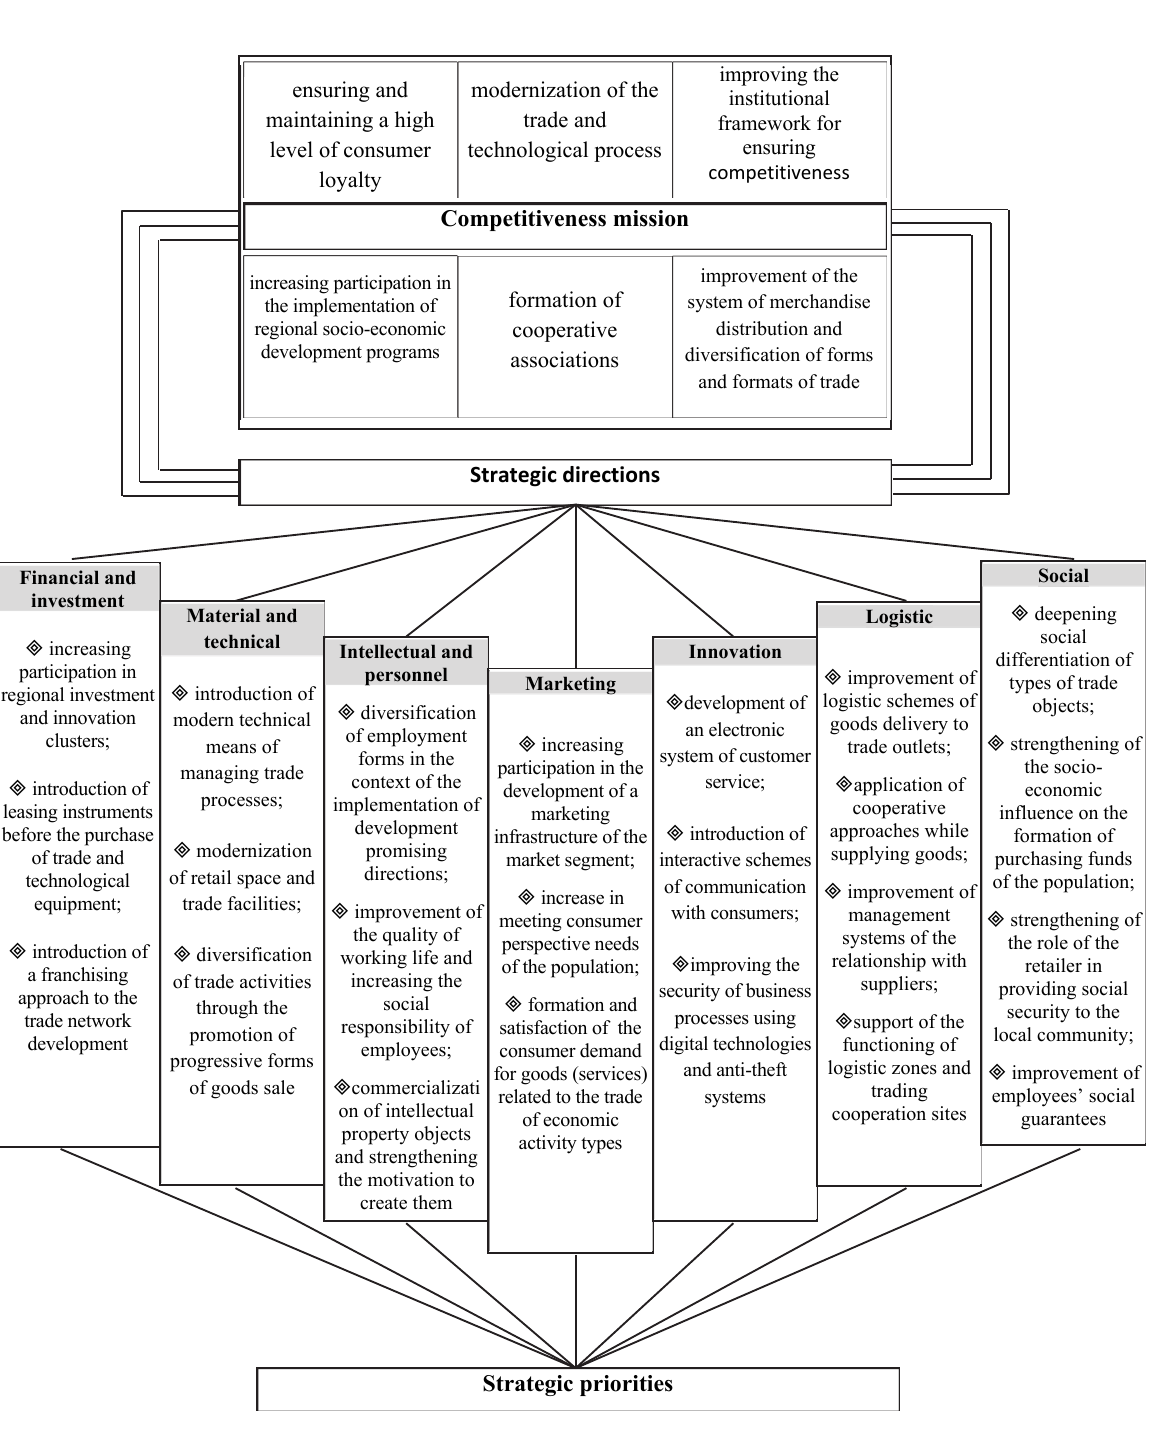
Fig. 3. Strategic principles of the formulation of the policy for ensuring competitive advantages of socially-oriented retailers Source: own